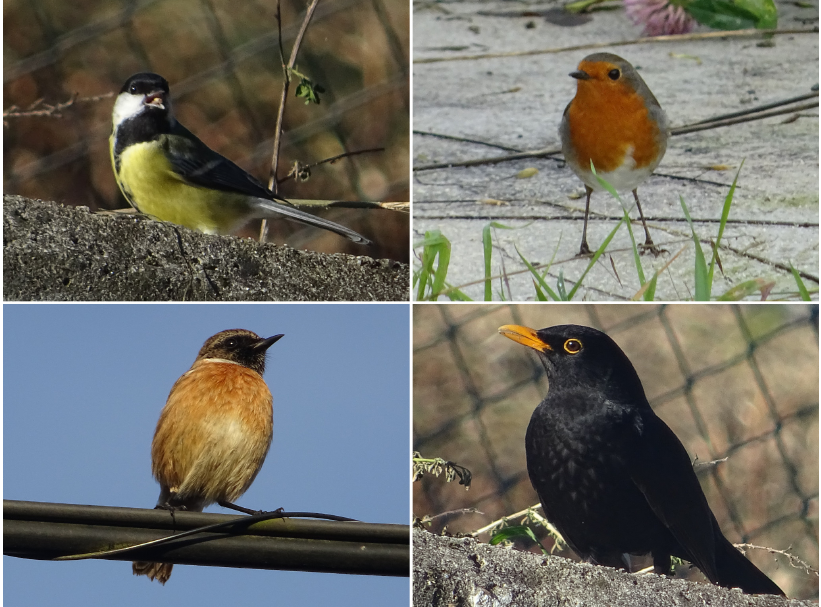
Figure 2. Although transformed by human activity, many riparian areas conserve a part of their wild animals: great tit ( Parus major ), European robin ( Erithacus rubecula ), whinchat ( Saxicola rubetra ), and common blackbird ( Turdus merula ) (Santiago de Compostela,